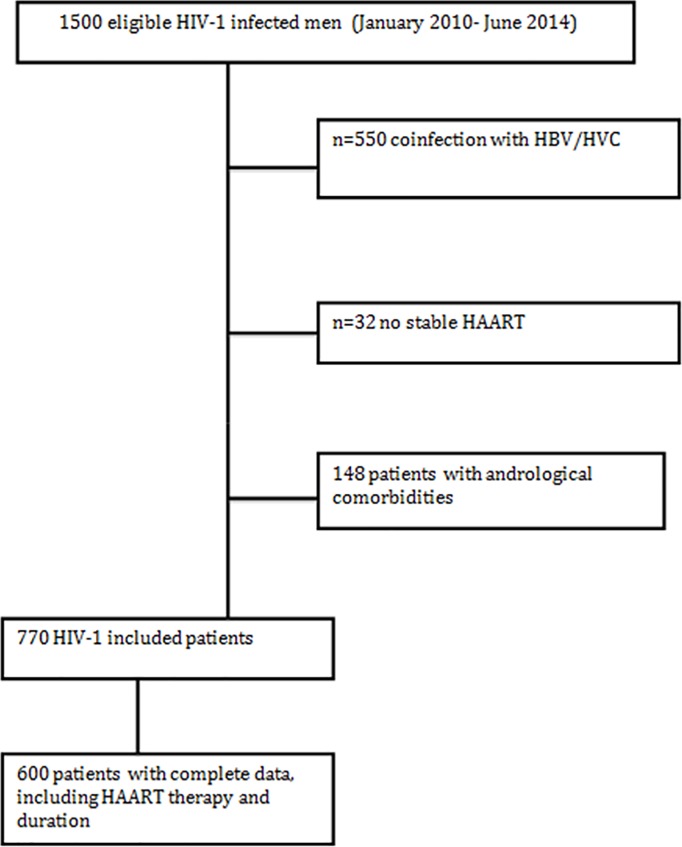
Flow chart of the study population.